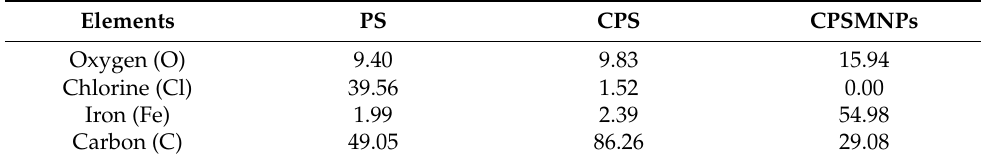
Table 1. EDX analysis, the elemental composition of PS, CPS, and CPSMNPs.